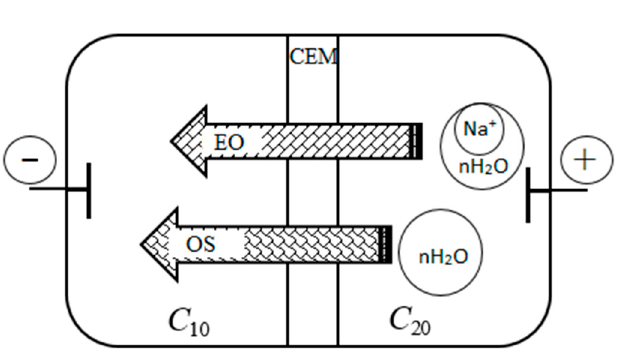
Figure 7. Schematic representation of co-directional electroosmotic (EO) and osmotic (OS) water fluxes through a cation-exchange membrane (CEM) in NaCl solutions.